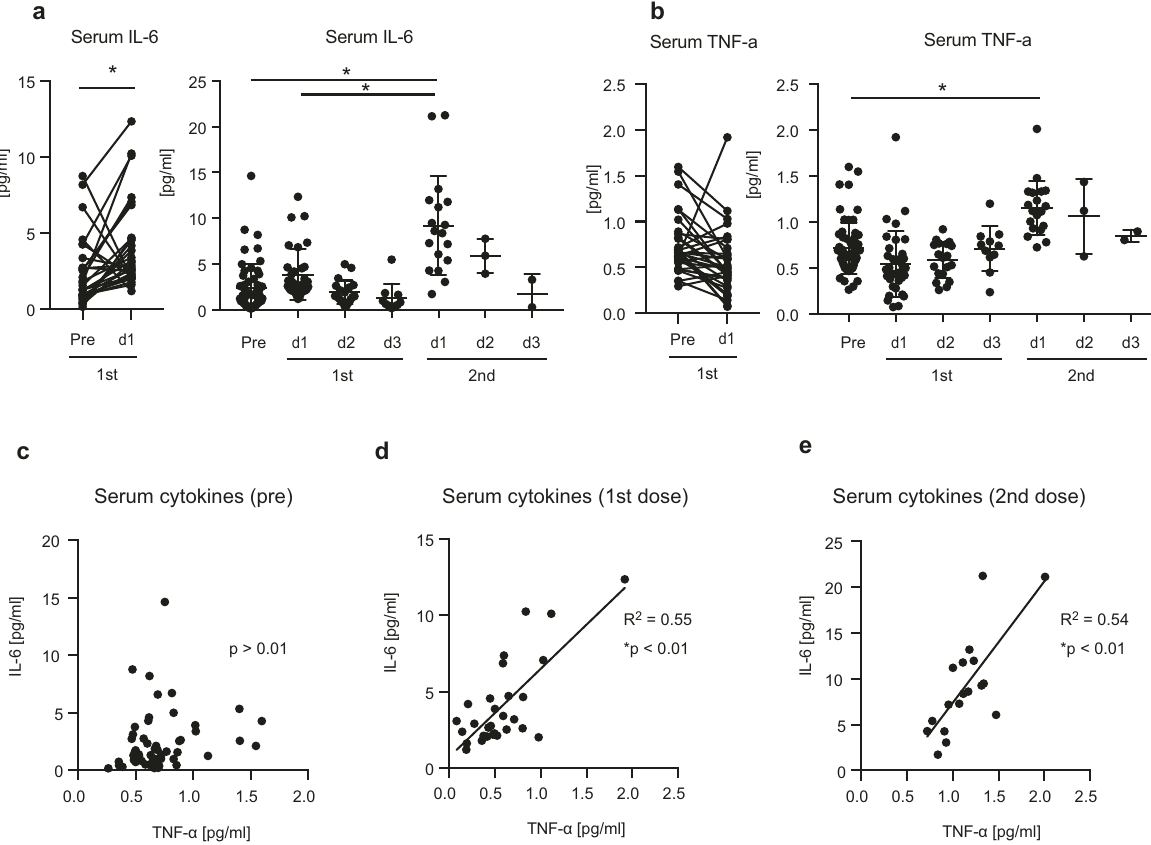
Fig. 3 Serum IL-6 and TNF- α levels before and after vaccination. a , b Sera were collected before (pre) and after the fi rst and second doses (days 1, 2, or 3). Serum IL-6 ( a ) and TNF- α ( b ) protein levels were determined by ELISA. Paired t -test (pre and post 1 day) and one-way ANOVA (each right panel) were performed (* p < 0.05). The bars represent mean ± standard deviation (SD). c – e Correlation between IL-6 and TNF- α protein levels at pre ( c ), 1 day after the fi rst dose, and 1 day after the second dose ( e ) was investigated. The coef fi cient of determination (R 2 ) and p -values were calculated (Pearson correlation test, * p < 0.05). Each dot represents a